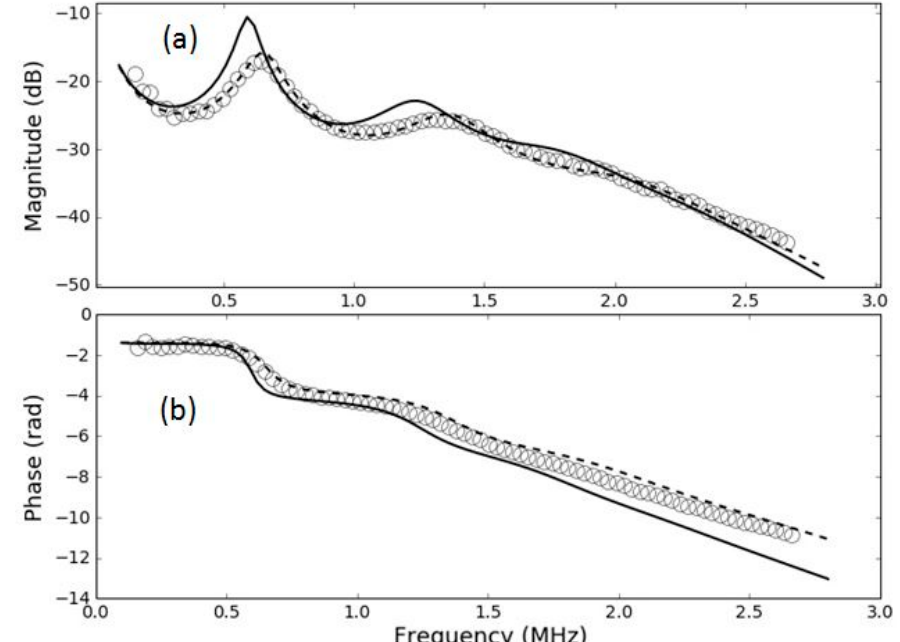
Figure 11. Magnitude ( a ) and phase ( b ) spectra of the transmission coefficient of the HS03 film in water immersion at normal incidence. Open circles: experimental data. Solid line: calculated response using film parameters obtained in [42]. Dashed line: calculated response using film parameters extracted from water immersion measurements.